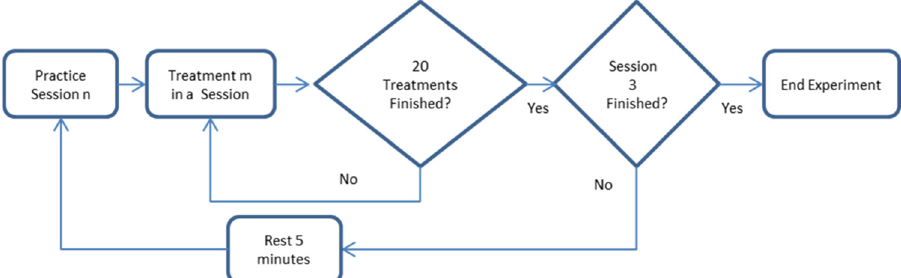
Figure 6. The procedure of the experiment implemented in this research. Every participant began each session with a practice task, A128 / ID 2. There were three sessions for each participant. Twenty treatments were randomly conducted in a session. After each session finished, the participants were allowed to rest for five minutes or until they felt they had recovered from any fatigue before beginning the next session.